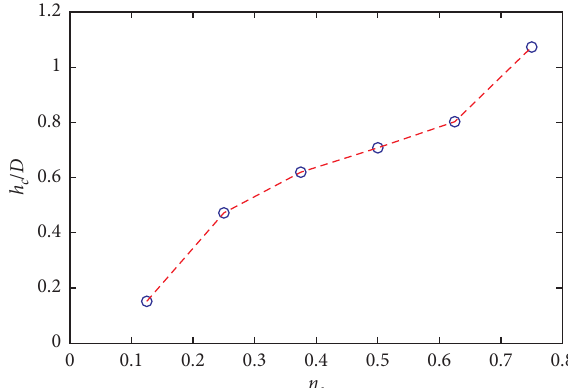
Figure 18: Variation in the settlement depth with the loading amplitude.